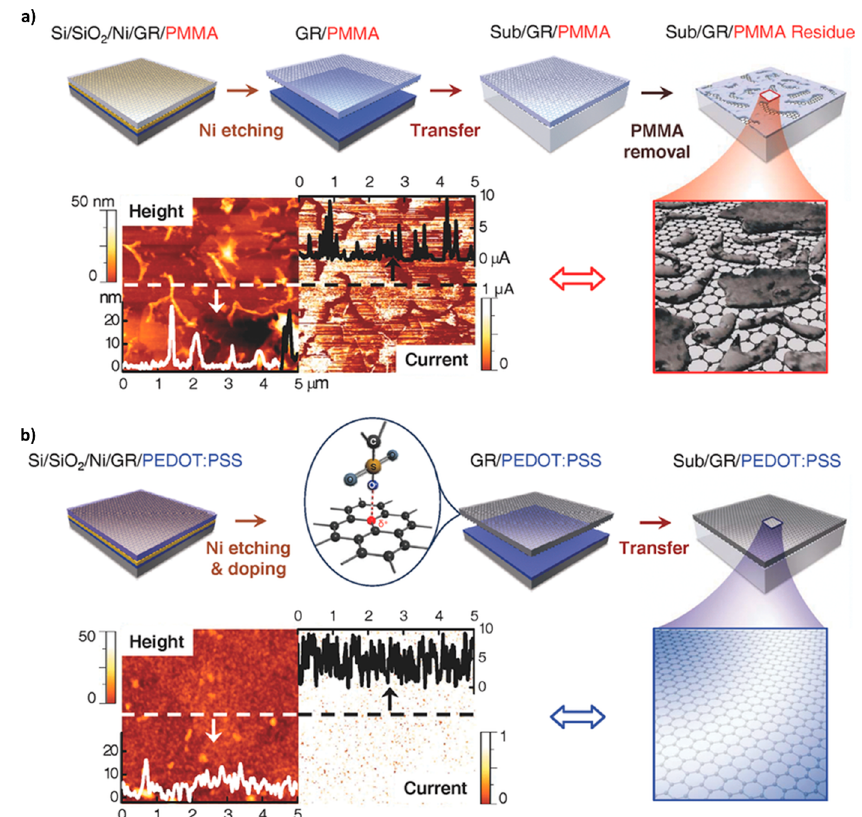
Figure 10. Schematic illustrations and representative conductive AFM analysis for ( a ) conventional transfer and ( b ) “doping transfer” methods. PMMA and PEDOT:PSS were used as the support films in both methods. Reprinted with permission from [183]. Copyright 2014, John Wiley & Sons Inc.